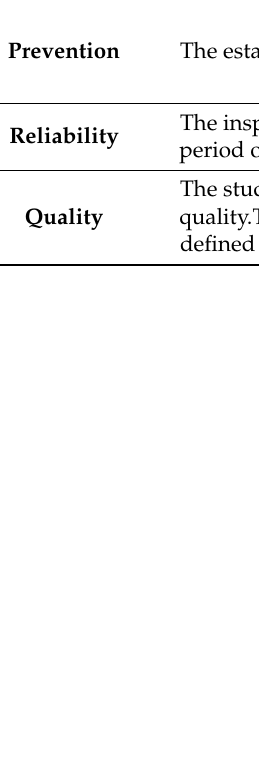
Table 5. IFCInfra4OM LODt Defined.